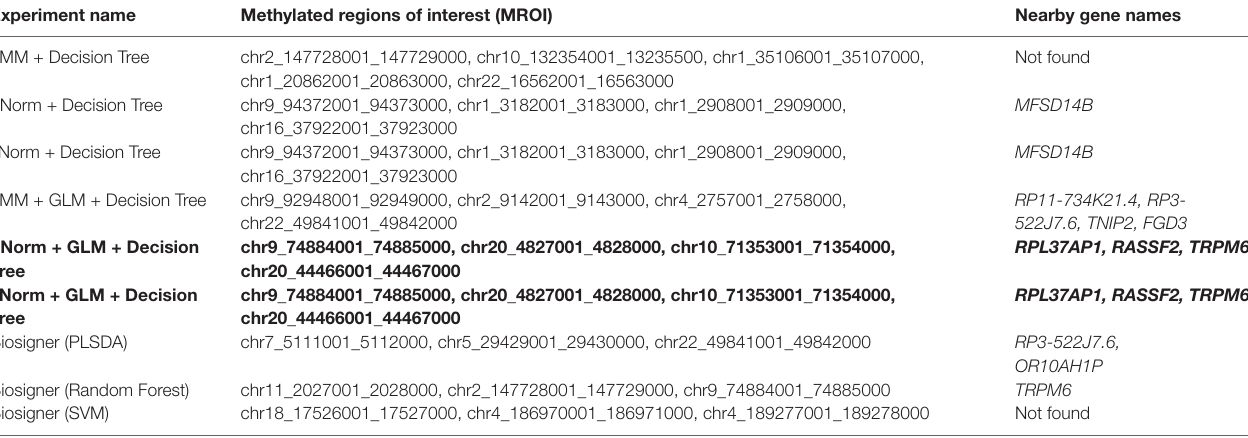
TABLE 7 | Methylated regions of interest (MROI) and candidate biomarker genes from methylomics analysis.